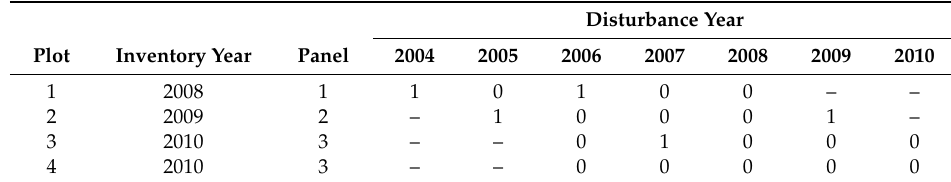
Table 1. Hypothetical example showing retrospective disturbance data collected for a five-year rotating panel forest inventory. “1” indicates a disturbance was recorded, “0” indicates a disturbance wasn’t recorded, and “–“ denotes an